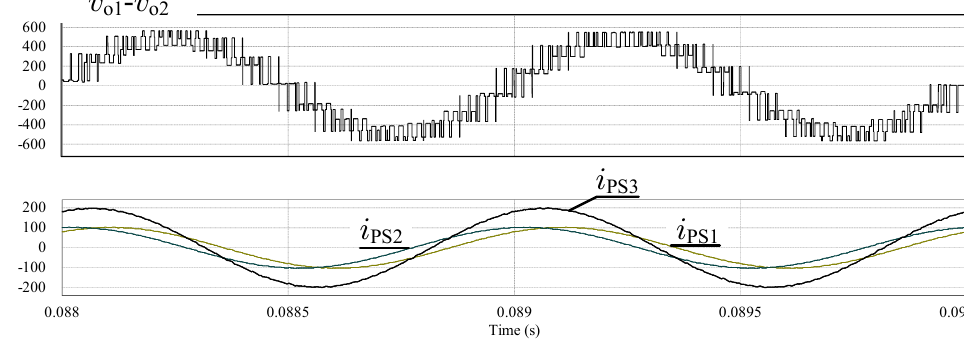
Figure 25. Converter’s line–to–line output (correspond to Figure 21) voltage and the current sharing among the PS shown in Figure 6—SVPWM modulation.